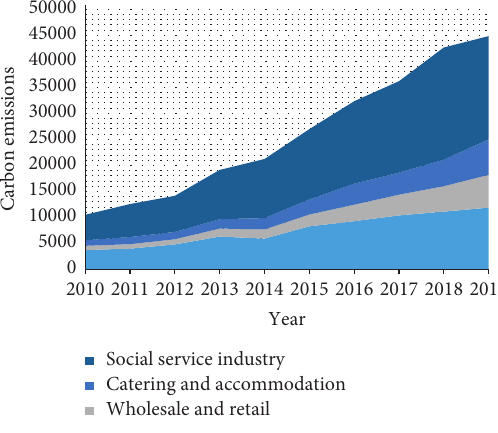
Figure 4: Carbon emissions by industry.